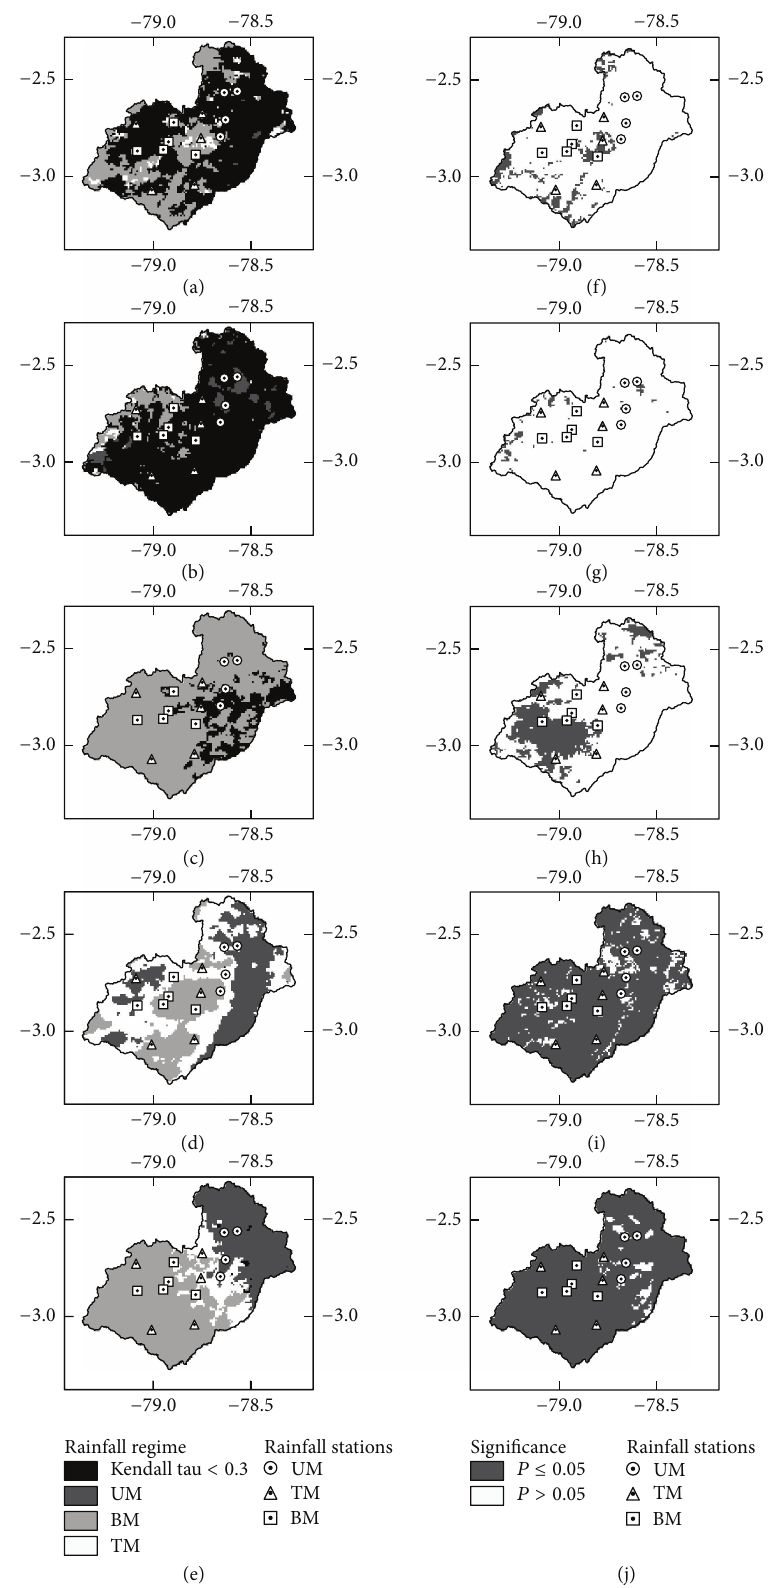
Figure 4: Pixel-wise maximum Kendall tau correlation between NPRs UM, BM, and TM for CF (a), LWP (b), ZMIT (c), CFM (d), and MLRM (f). Only correlations greater than 0.3 are plotted. Corresponding significance of maximum correlation at 0.05 level for CF (f), LWP (g), ZMIT (h), CFM (i), and MLRM